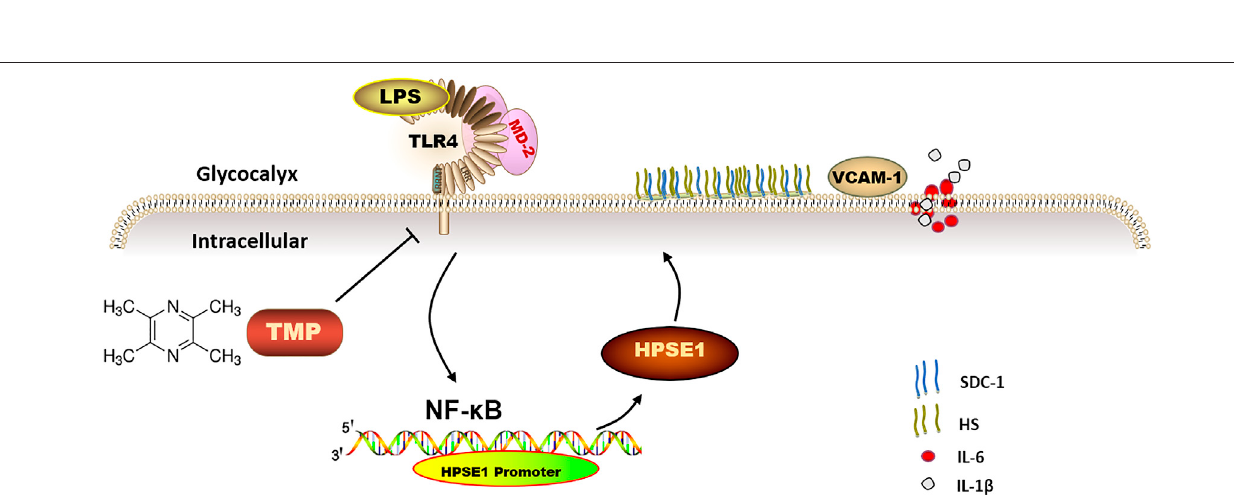
Frontiers in Pharmacology |